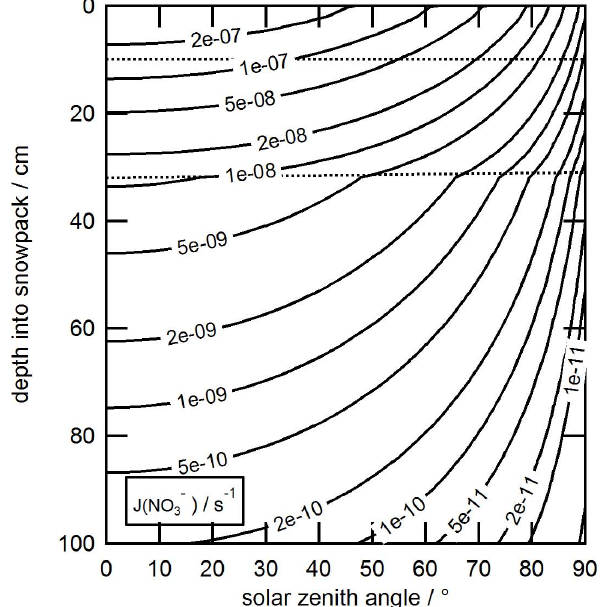
Fig. 4. Nitrate photolysis rate coefficient contours for a Dome C snowpack (as described in Table 1), plotted against solar zenith an- gle and depth into the snowpack. Horizontal dashed lines represent the depths at which the snowpack stratigraphy